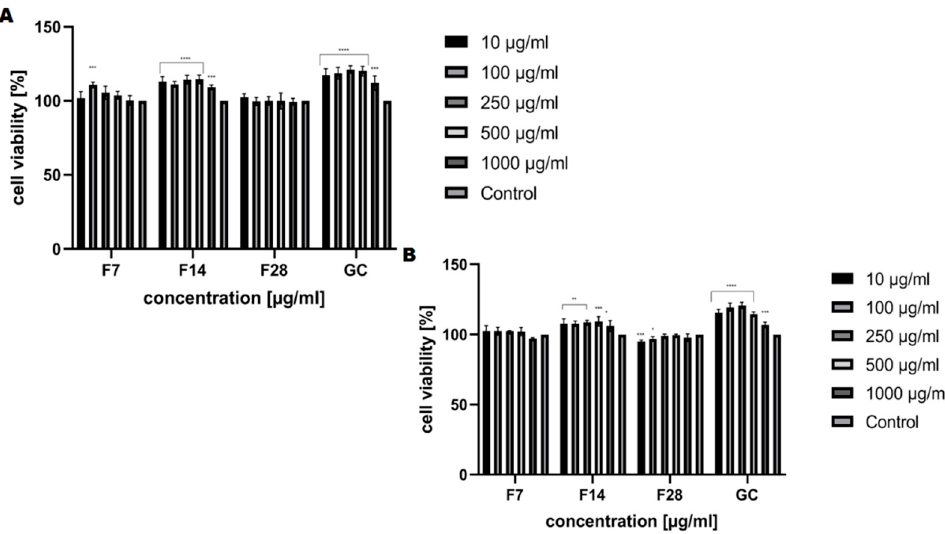
Figure 8. The reduction of resazurin after 24 h exposure to the ferments obtained from green coffee beans (1–1000 µg/mL) in cultured ( A ) fibroblasts (BJ) and ( B ) keratinocytes (HaCaT). Data are the mean ± SD of three independent experiments, each of which consists of three replicates per treatment group. For BJ, **** p < 0.0001, *** p < 0.0007 versus the control (100%). For HaCaT, **** p < 0.0001 *** p < 0.0008, ** p < 0.003, * p < 0.04 versus the control (100%).